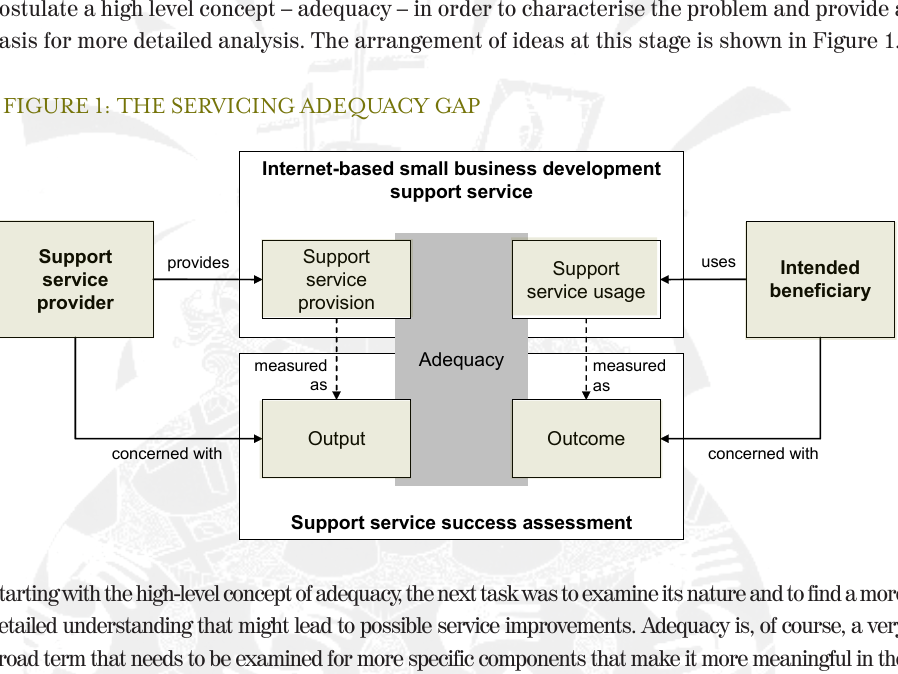
FIGURE 1: THE SERVICING ADEQUACY